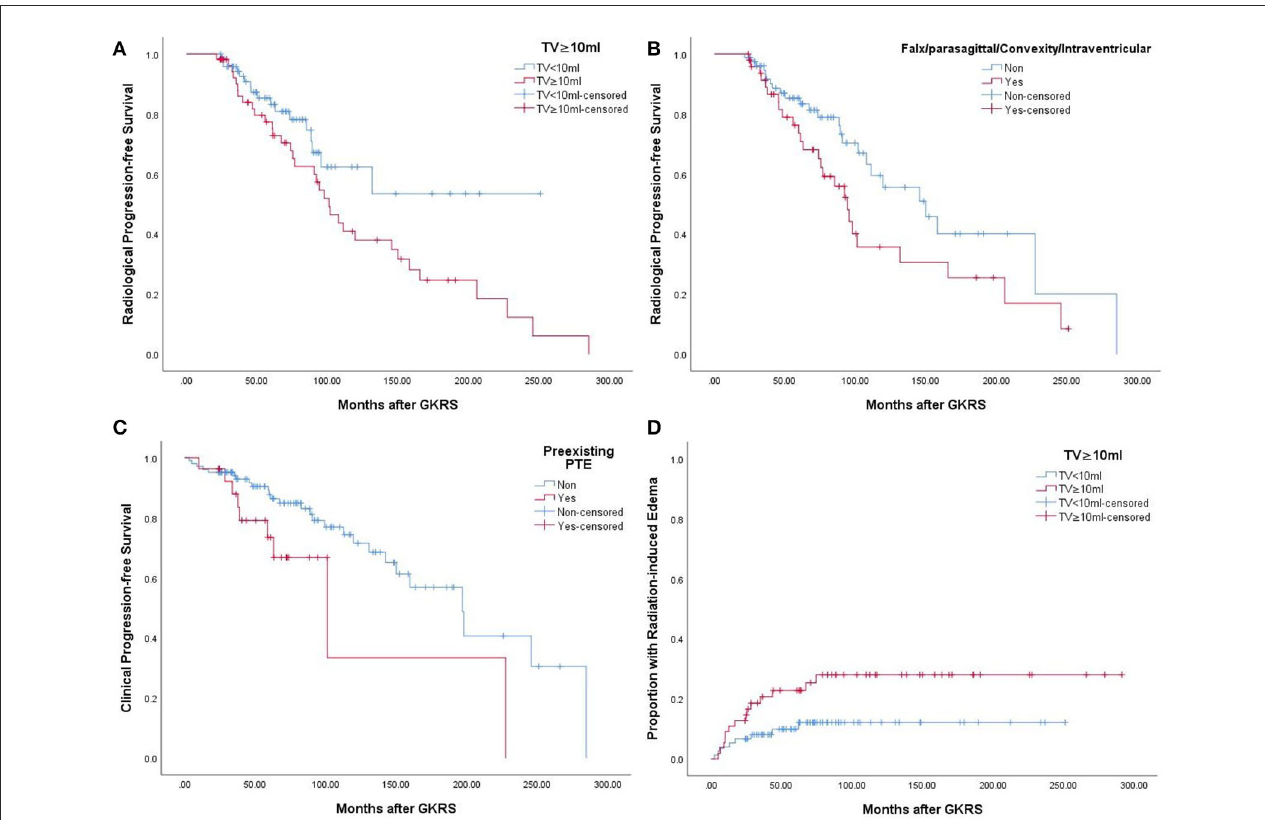
FIGURE2 (A) Kaplan–Meier curve of radiological PFS of tumor volume ≥ 10 ml VS < 10 ml in the entire series ( p = 0.043). (B) Kaplan–Meier curve of radiological PFS of falx/parasagittal/convexity/intraventricular location in the entire series ( p = 0.047). (C) Kaplan–Meier curve of clinical PFS of preexisting PTE in the entire series ( p = 0.040). (D) Kaplan–Meier curve of radiation-induced edema of tumor volume ≥ 10 ml VS < 10 ml in the entire series ( p =